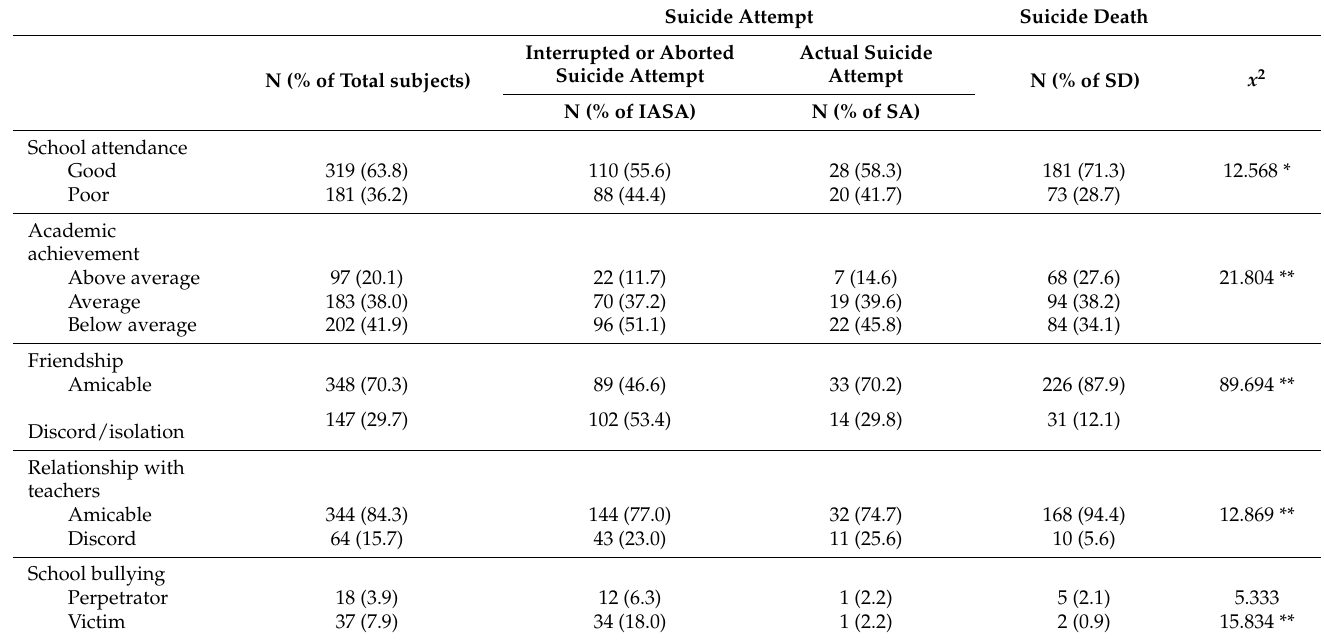
Table 3. Comparison of variables related to school